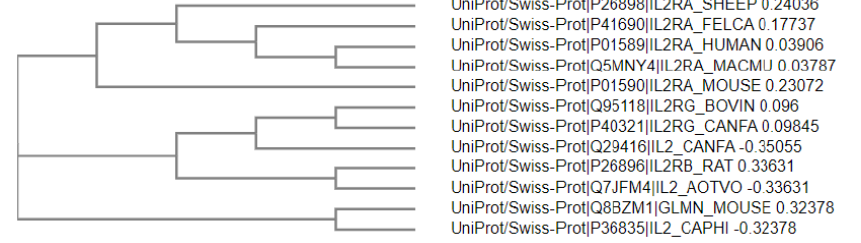
Figure 3. Phylogenetic tree of POLDIP3 homologs. GeneBank was used to align the different homologs of POLDIP3. The phylogenetic tree of POLDIP3 homologs was created using the Simple Phylogen from EMBL-EBI.